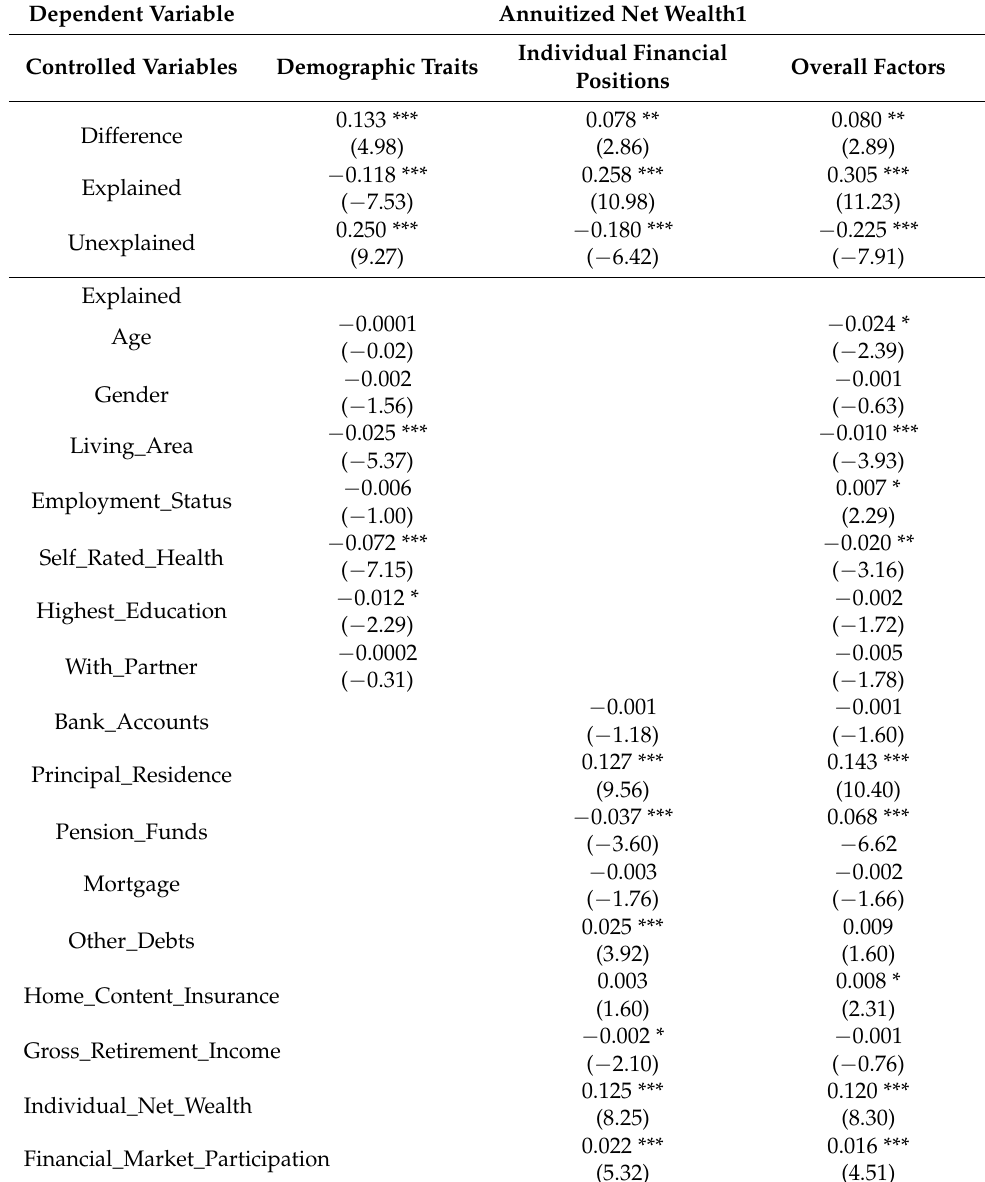
Table 5. Postretirement annuitized net wealth decomposition in Australia and New